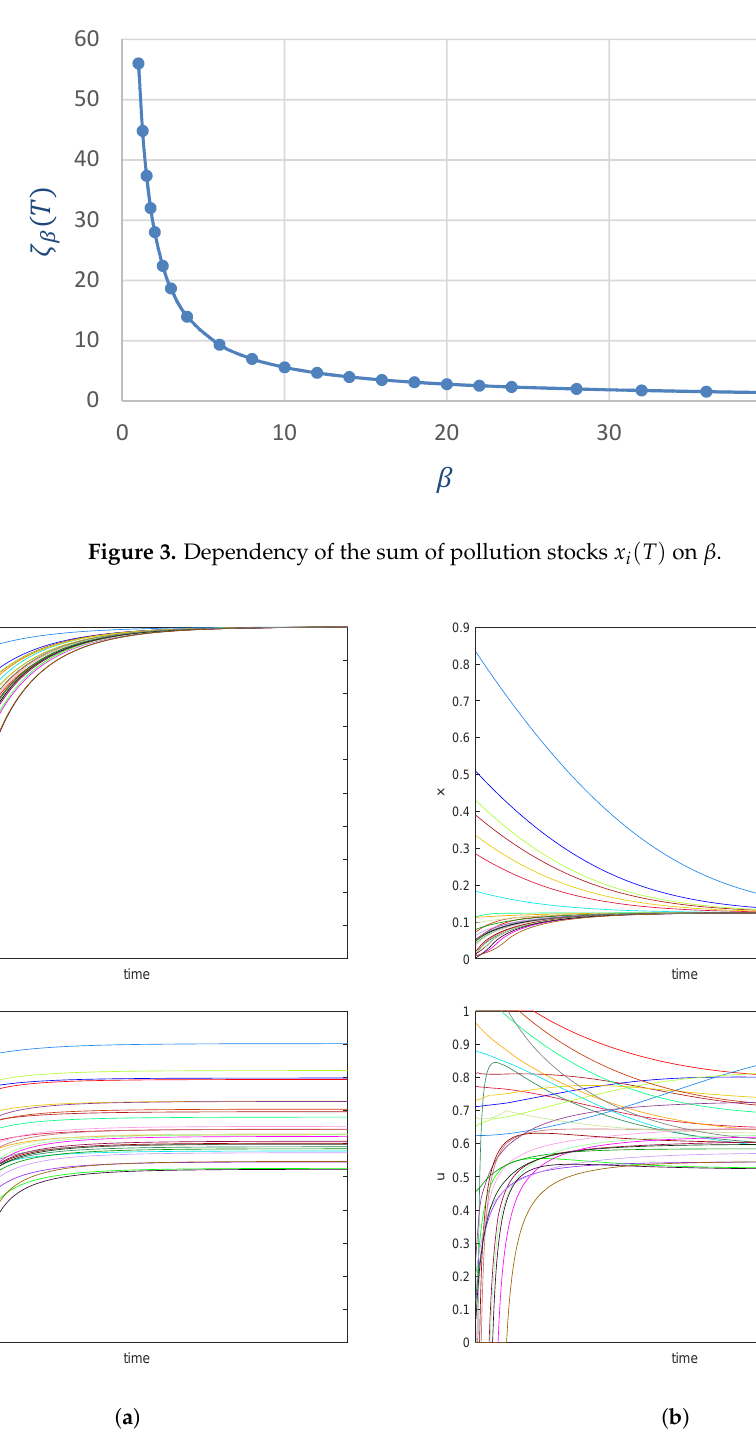
Figure 4. Pollution stock x and investment u into environmentally friendly policies for each player with an either weak or strong external control on pollution costs. ( a ) Weak external control of pollution costs ( β = 2); ( b ) Strong external control of pollution costs ( β =